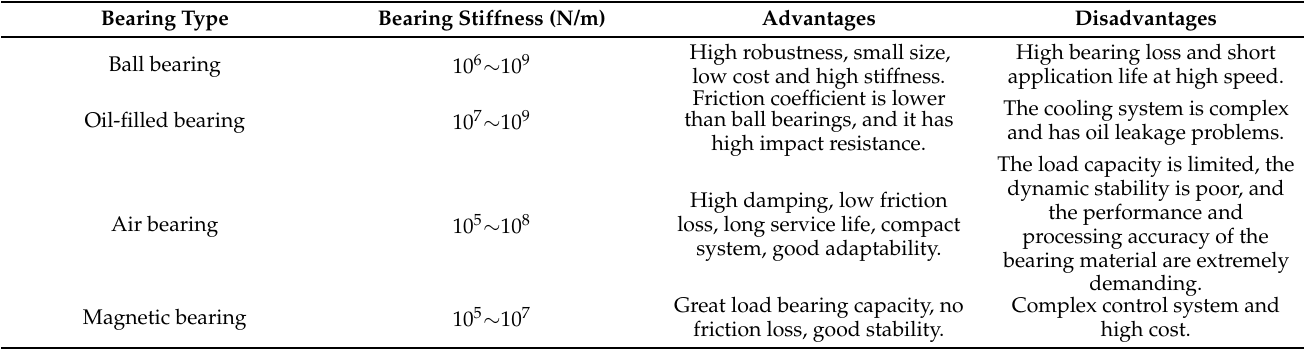
Figure 23. Bearing distribution of high-speed PM motor. Table 3. Application characteristics of several types of